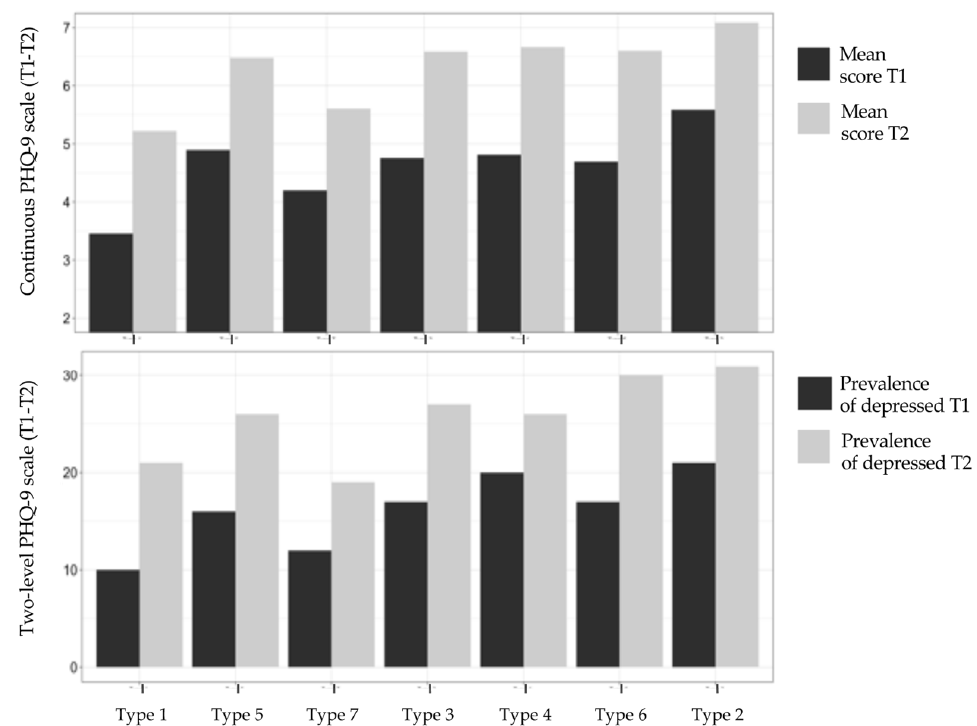
Figure 2. Mental health outcomes by employment trajectory type before and after the onset of the COVID-19 pandemic. Note: Formal employment trajectories: Type 1, Type 5, and Type 7. Informal employment trajectories: Type 3, Type 4, and Type 6. Non-employment trajectory: Type 2.